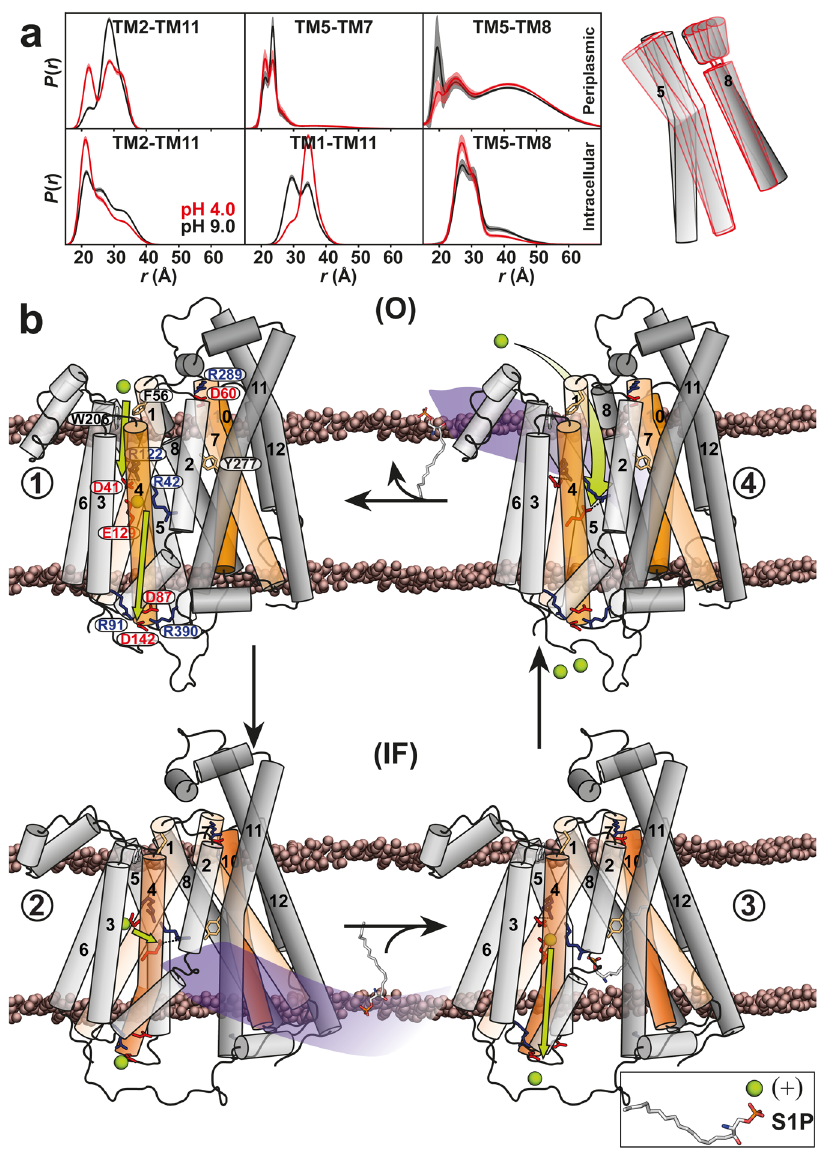
Fig. 10 | Proposed model of S1P/H + antiport in Hn Spns. a Proton-dependent conformational dynamics are signi fi cantly enhanced on the periplasmic side, pro- viding a pathway for ligand exchange. b In thismodel, the stable resting state isIF, andOisofrelativelyhighenergy.Sidechainsofthefunctionallyconservedresidues are represented as sticks. Asp41 protonation promotes the Glu129 deprotonation and formation of a charge pair with Arg42 ( 1 ). Subsequently, the released proton translocates to the intracellular side, where the acidic residues of the charge-relay network(e.g.,Asp142)areprotonated,stabilizingtheIFconformationforsubstrate binding from the intracellular side ( 2 ). Proton transfer from Asp41 to Glu129